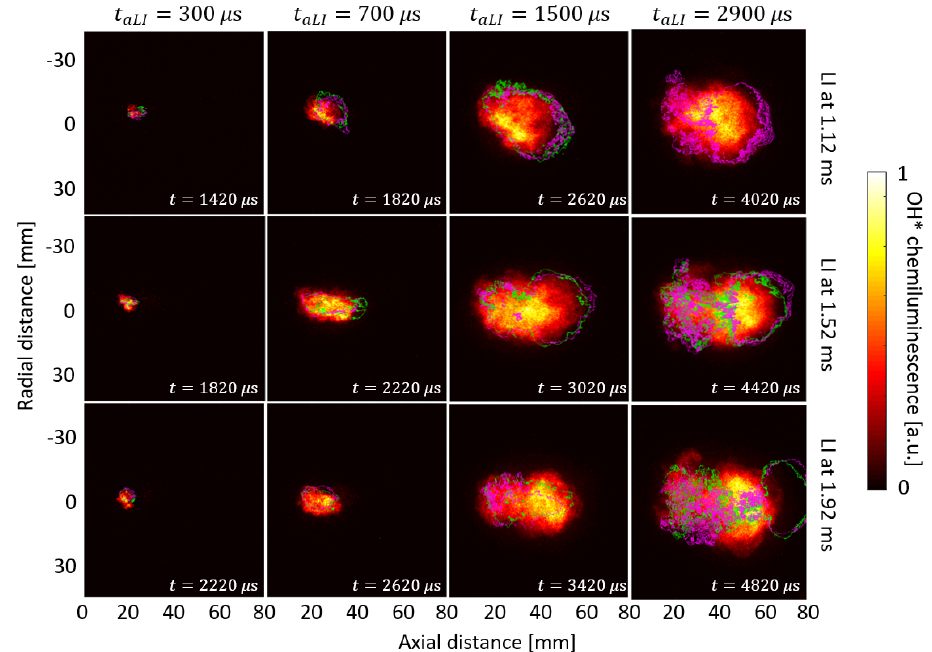
Figure 7. The color scale shows the ensemble-averaged normalized OH* chemiluminescence from the experiments. The green and magenta isolines represent the flame boundary from LES. The green and magenta colors allow to identify different realizations. The images are ranked by the time after laser ignition ( t aLI ). The time after the start of injection is shown in the bottom right corner of each